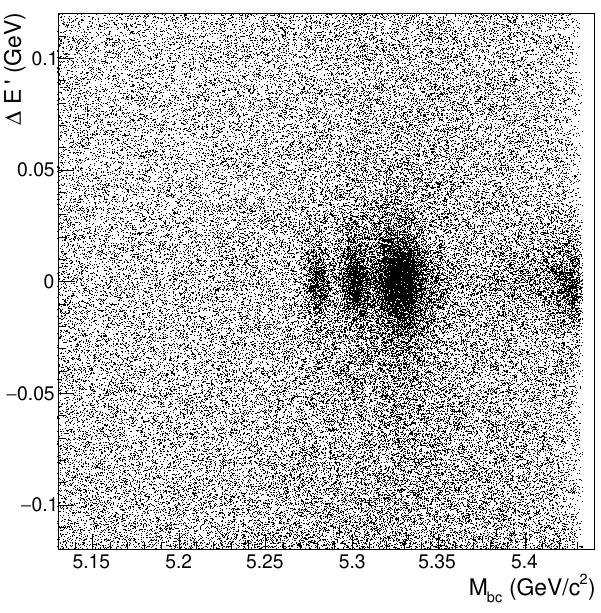
Figure 2 . The ∆ E 0 versus M bc distribution for the Υ(5 S ) data.